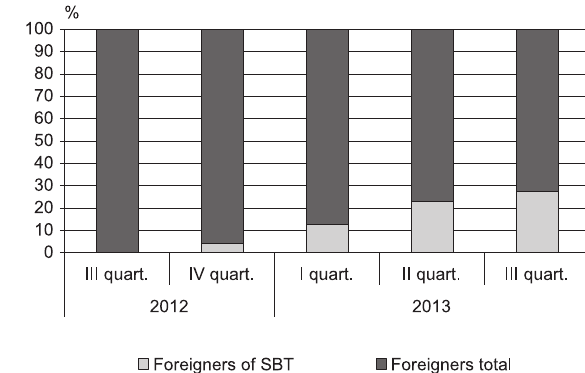
Fig. 4. Structure of individual traffic of foreigners on the Polish-Kaliningrad border, including those with documents issued under the small border traffic (SBT) agreement Source: own study based on www.strazgraniczna.pl